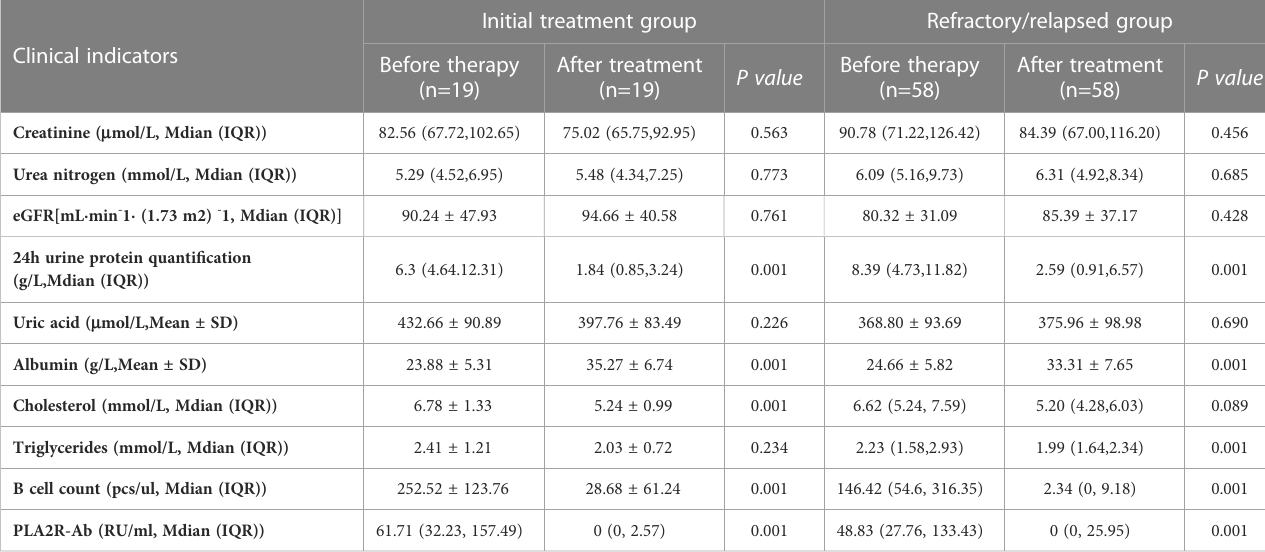
Clinical indicators